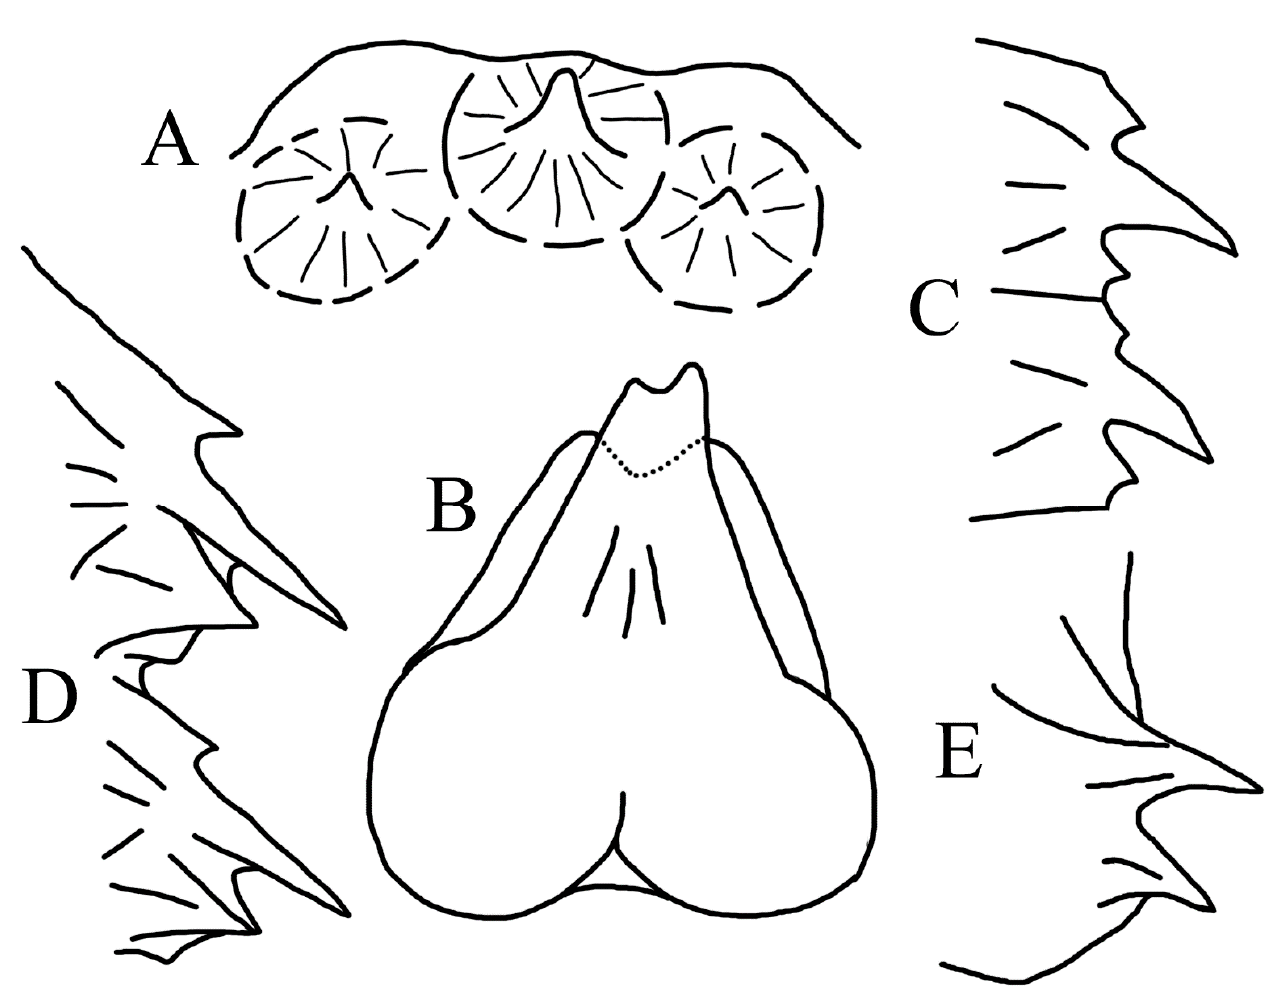
Figure 2. Esca and squamation of H. andriashevi Bradbury, 1988, from BSKU 23697, 51.0 mm SL. ( A ). Rostral tubercles. ( B ). Esca. ( C ). Tubercles on disk margin. ( D ). Tubercles on tail. ( E ). Subopercular tubercle.